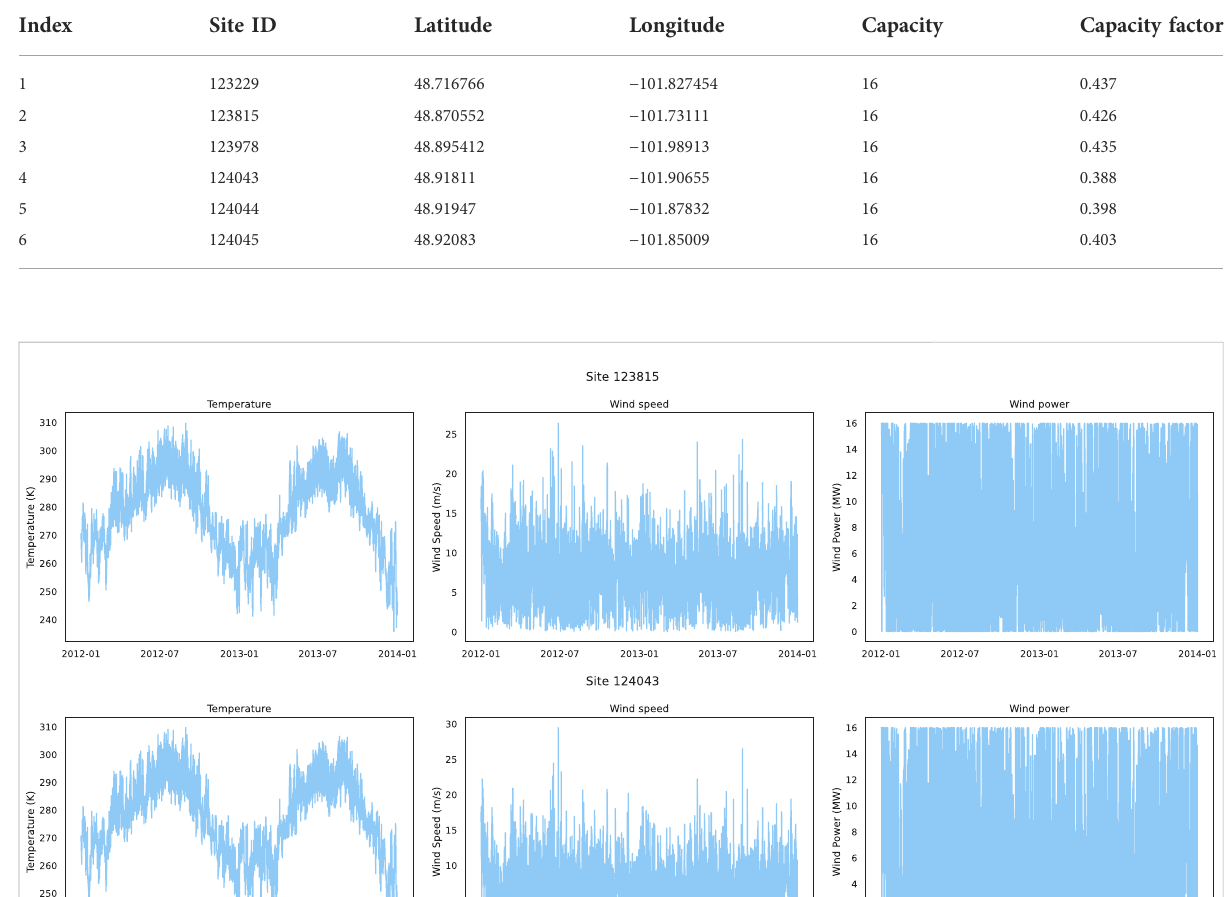
TABLE 1 Information of six wind farms.